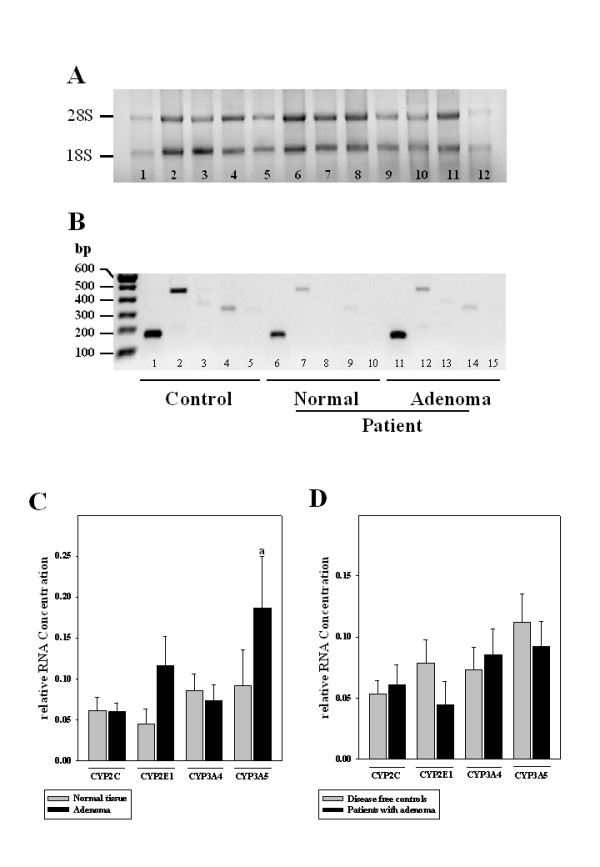
CYP3A5, CYP2E1, CYP3A4, and CYP2C mRNA expression in colon mucosa of patients with adenoma and disease-free controls. (A) Representative agarose gel of mRNA integrity. Lane 1 and 12 = positive control, lane 2–11 = RNA extracted from colonic mucosa biopsies. (B) Representative photomicrograph of RT-PCR products of two subjects. All measurements were carried out in triplicate. Lanes 1, 6, 11: Histone 3.3; Lanes 2, 7, 12: CYP3A5; Lanes 3, 8, 13: CYP2E1; Lanes 4, 9, 14: CYP3A4; Lanes 5, 10, 15 = CYP2C, bp = base pairs. (C) Quantitative analysis of CYP2C, CYP2E1, CYP3A4, and CYP3A5 mRNA expression in normal colon mucosa and in colonic adenoma of patients. Results are normalized to histone 3.3 expression. Data are means ± SEM, ap < 0.05 compared to normal tissue. (D) Quantitative analysis of CYP2C, CYP2E1, CYP3A4, and CYP3A5 mRNA expression in normal colon mucosa of patients with colonic adenoma and disease-free controls. Results are normalized to histone 3.3 expression. Data are means ± SEM, ap < 0.05 compared to disease-free controls.